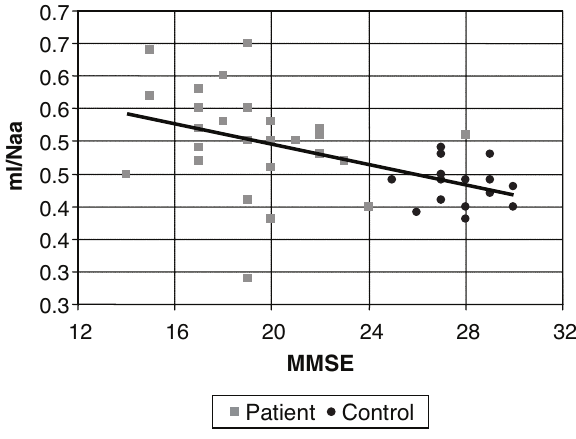
Figure 5. Scatter plot for MMSE and ml/Naa in the cingulate. ml/ Naa, mioinositol/N-acetil-aspartate